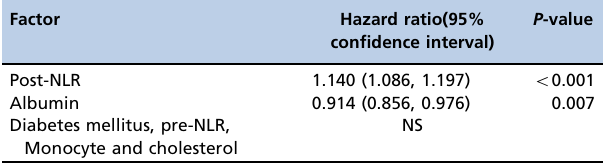
Figure 3 - Survival outcome comparison between groups A and B (P o 0.001). Table 3 - Multivariate analysis of factors affecting overall amputation in patients with critical limb